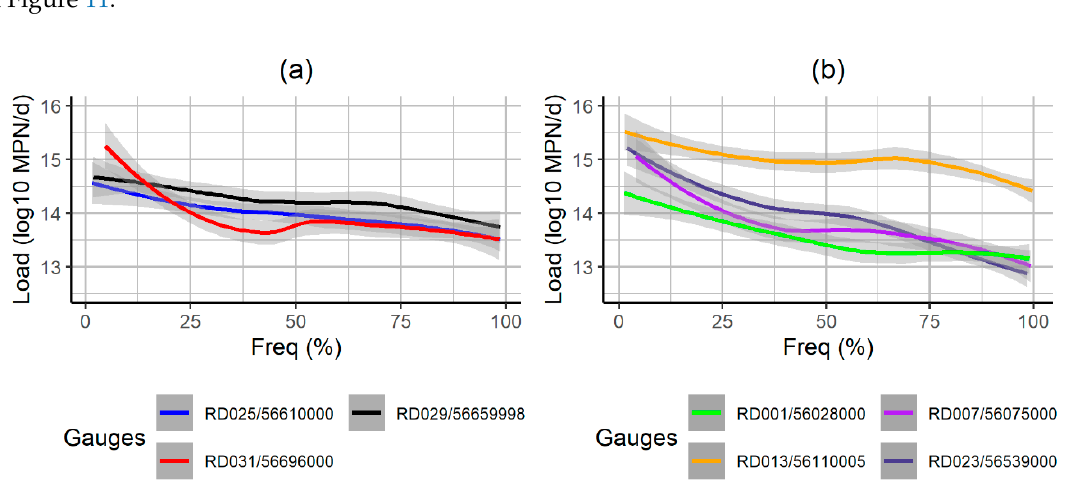
Figure 11. Tendency curves (Loess) of observed points in the gauges within the ( a ) Piracicaba and ( b ) Piranga basins.